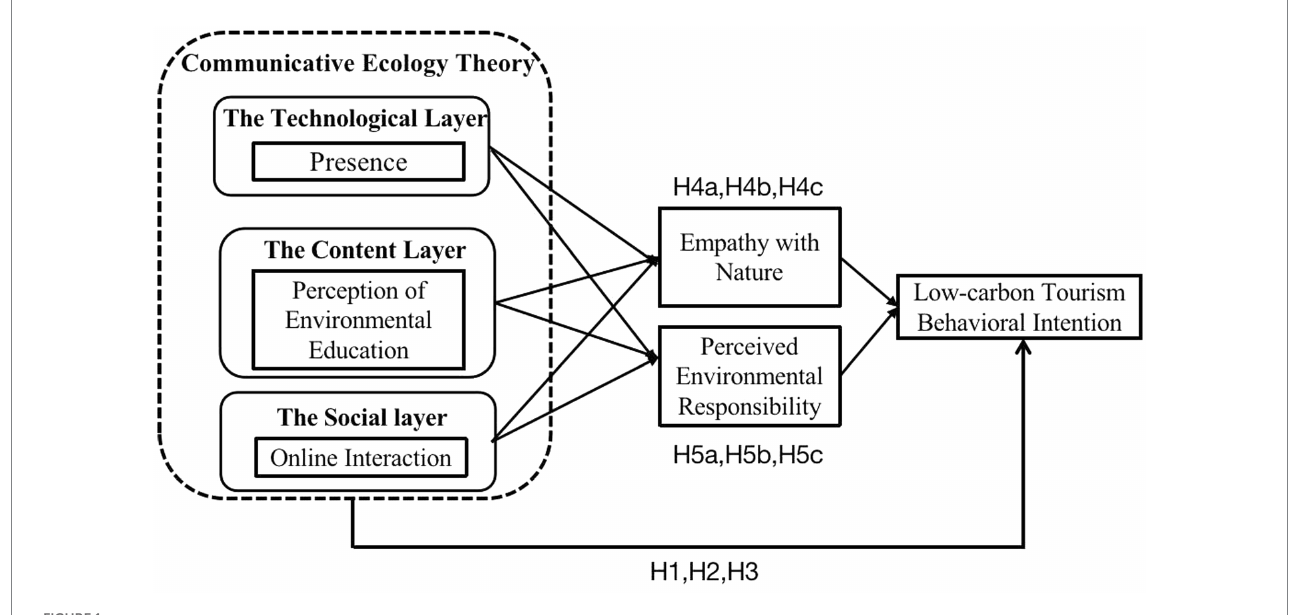
FIGURE 1 Theoretical